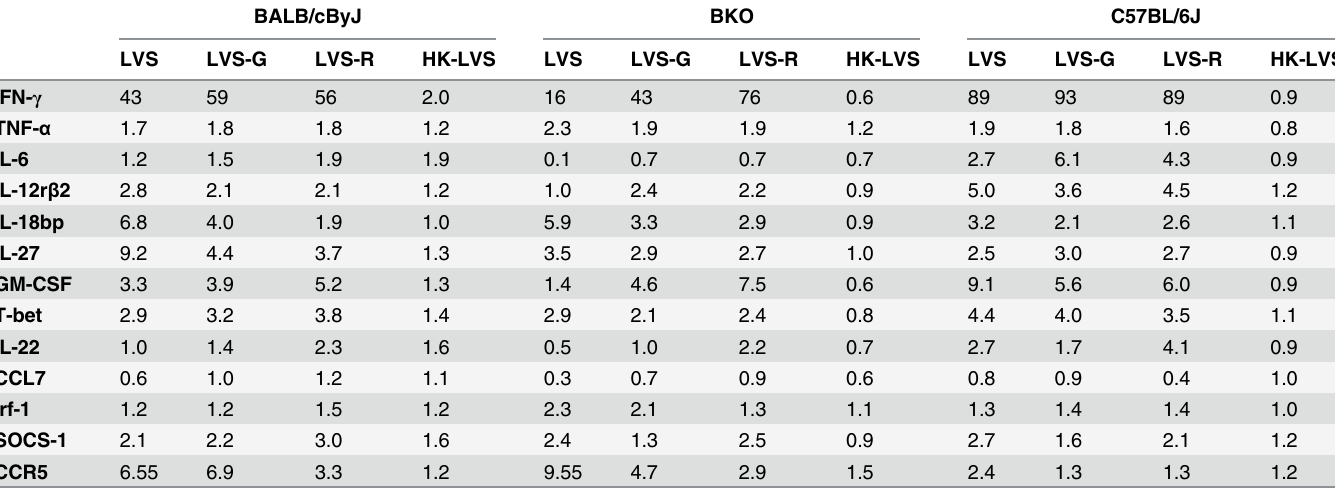
Values indicate median fold change of the indicated genes, compared to naive cells; values derived from analyses of splenocytes of BALB/cByJ, BKO, and C57BL/6J mice were calculated from seven, four, and four independent experiments,